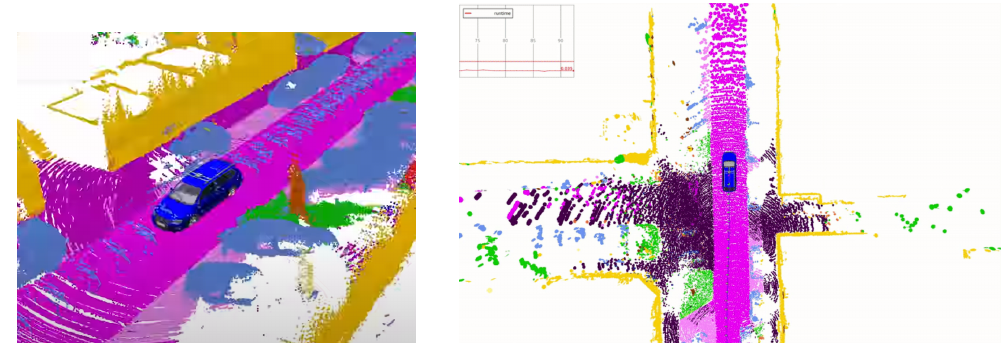
Figure 4. Using environment features to create a semantic map. SUMA++ [86] operating under an environment using LiDAR sensors, which provides rich information to understand the environment around the vehicle.